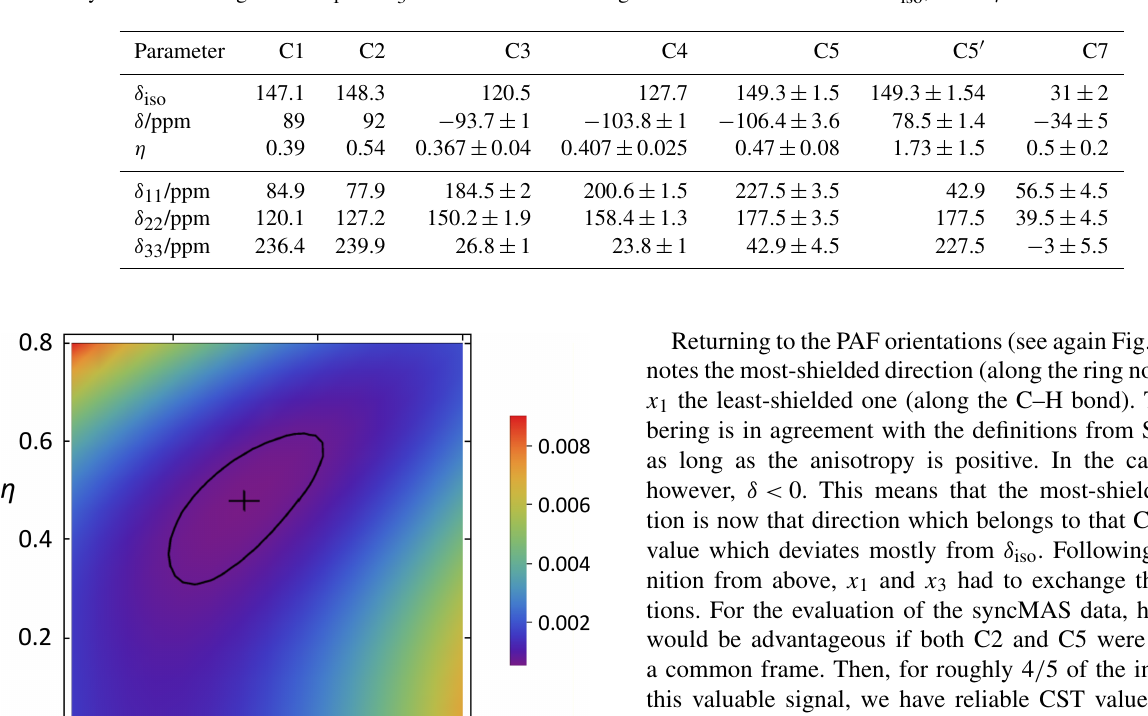
Table 2. CST parameters of all 13 C positions in PC. The data for C1 and C2 are from Robyr et al. (1998). Those for C3, C4, C5 and C7 were obtained by the polynomial procedure. For C5, a decomposition procedure was applied (see text). Column C5 (cid:48) contains CST data of C5 but obtained by mutual exchange of the x 1 and x 3 axes. In all cases the eigenvalues are calculated from δ iso , δ and η .